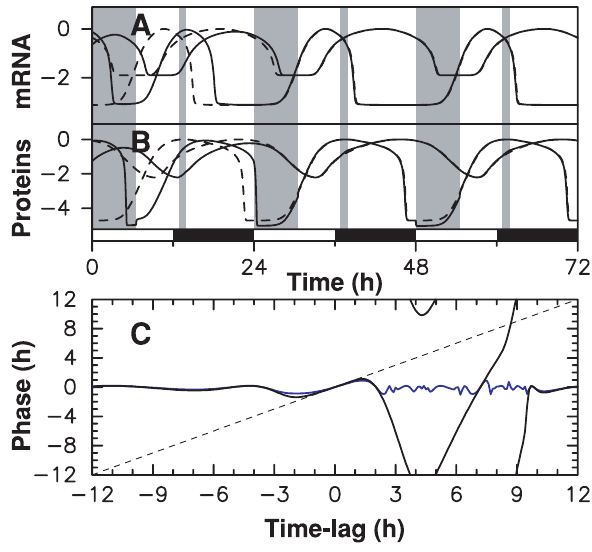
Figure 7. Resetting properties of a model with gated coupling. TOC1 (resp. CCA1) degradation rate is multiplied by 2.1 (resp., by 0.6) from ZT0 to ZT6.5 (resp., from ZT12.8 to ZT13.95). After phase-shifting the day/night cycle by 12 hours, (A) mRNA and (B) protein time profiles (logarithmic scale) of numerical solutions (solid lines) converge rapidly to the nominal profile (dashed lines). (C) Residual phase shift one day (black) and five days (blue) after a phase shift ranging from 2 12 to 12 hours has been